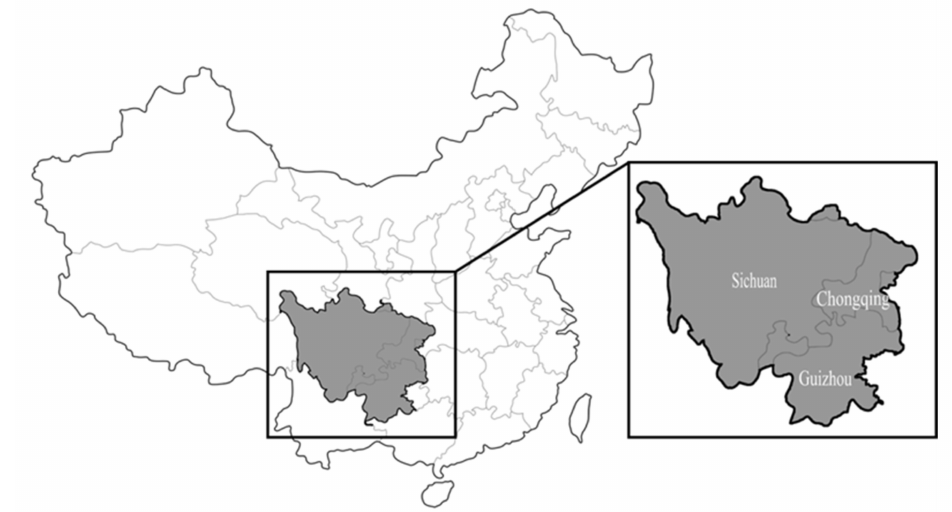
Figure 1. Area under the jurisdiction of Chengdu Railway Administration.